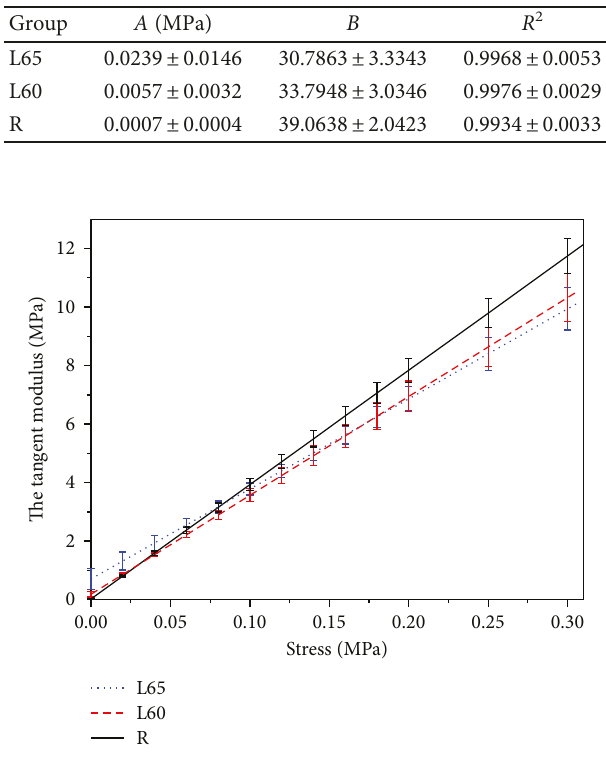
Figure 8: The stress-tangent modulus curves of corneal strips.